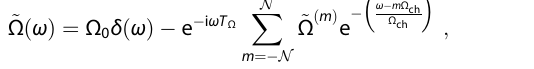
Fig. 8 Gate error as a function of control and hardware parameters. a Optimized gate error, 1 (cid:5) F gate , as a function of the number of Fourier components, N ch , and their bandwidth, Ω ch . b Gate error as a function of the noise parameter, σ , using 100 different combinations of random numbers, X ð m Þ , (black R = I